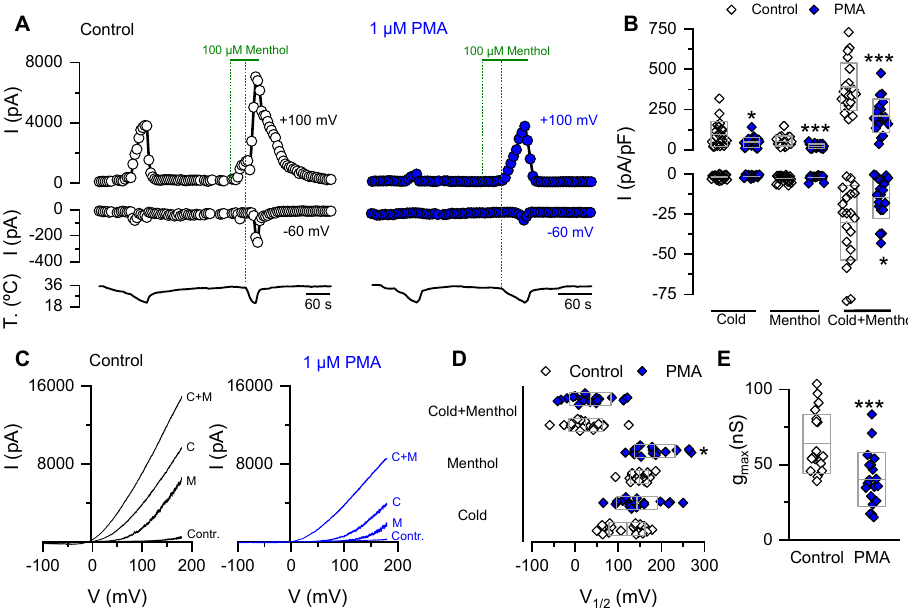
Figure 2. PKC activation reduces the g max in HEK-293 cells expressing mTRPM8 channels. ( A ) Time course of whole cell current development at +100 and − 60 mV in HEK-293-mTRPM8-myc stable cell line preincubated for 10 min with (right panel) or without (left panel) 1 µM PMA. ( B ) Scatter plot with mean ± S.D. of all values corresponding to the maximal current density at +100 and − 60 mV. Mean whole-cell capacitance for control cells was 14.6 ± 0.6 pF, vs. 15.6 ± 0.6 pF for treated cells, n = 20 and 19, respectively; p > 0.05, unpaired Student’s t test. ( C ) Whole-cell I-V relationships at 34 °C in control solution (Contr.), at 20 °C in control solution (cold (C)), menthol at 34 °C (M), and menthol at 20 °C (C + M), for each condition. ( D – E ) Box plot with data points; the center line of the box represents the mean values, whereas the top and bottom of the box represent the SD of V 1/2 values ( D ) and g max estimated in the cold+menthol condition ( E ). Statistical significance was assessed with a two-tailed unpaired Student’s t test; * p < 0.05 and *** p < 0.001. Control, n = 20 and PMA, n = 19.